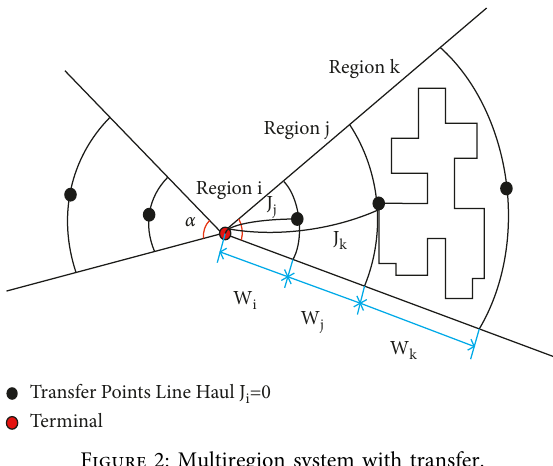
Figure 2: Multiregion system with